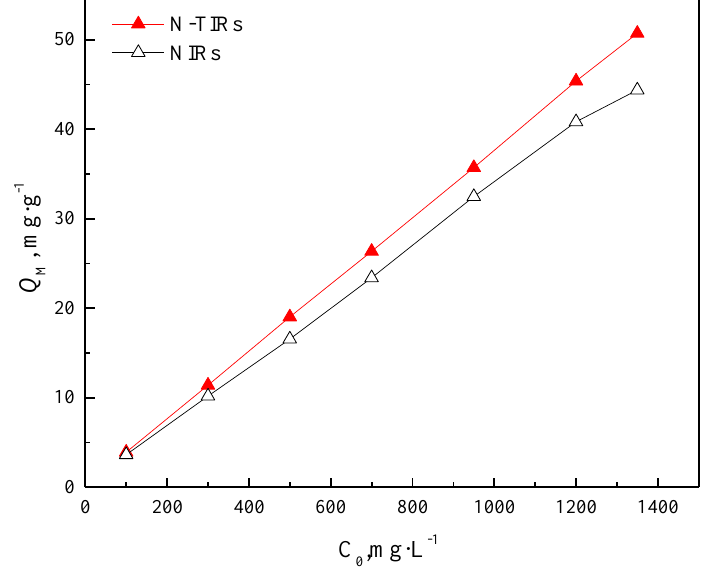
Figure 6. Effects of initial V(V) concentration on the adsorption capacity of the N-TIRs and NIRs for V(V).